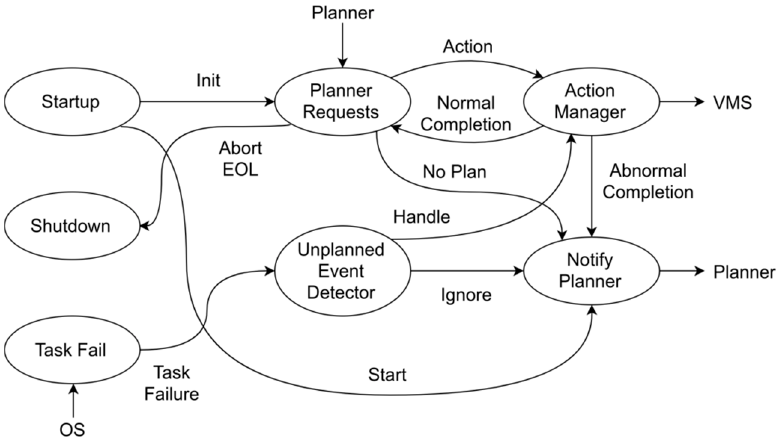
Figure 20. The ACE collaboration diagram.